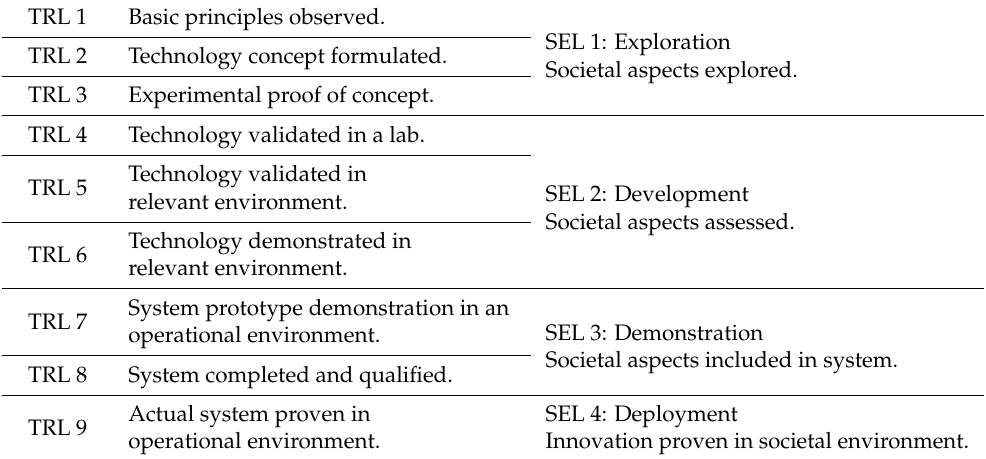
Table 3. Technology readiness Levels and SEL levels. TRL 1 Basic principles observed. explored.TRL